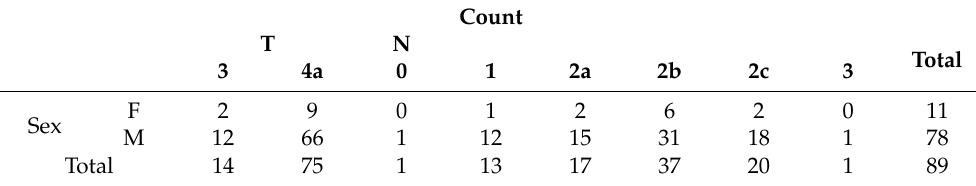
Table 5. Sex distribution of tumours T and N.